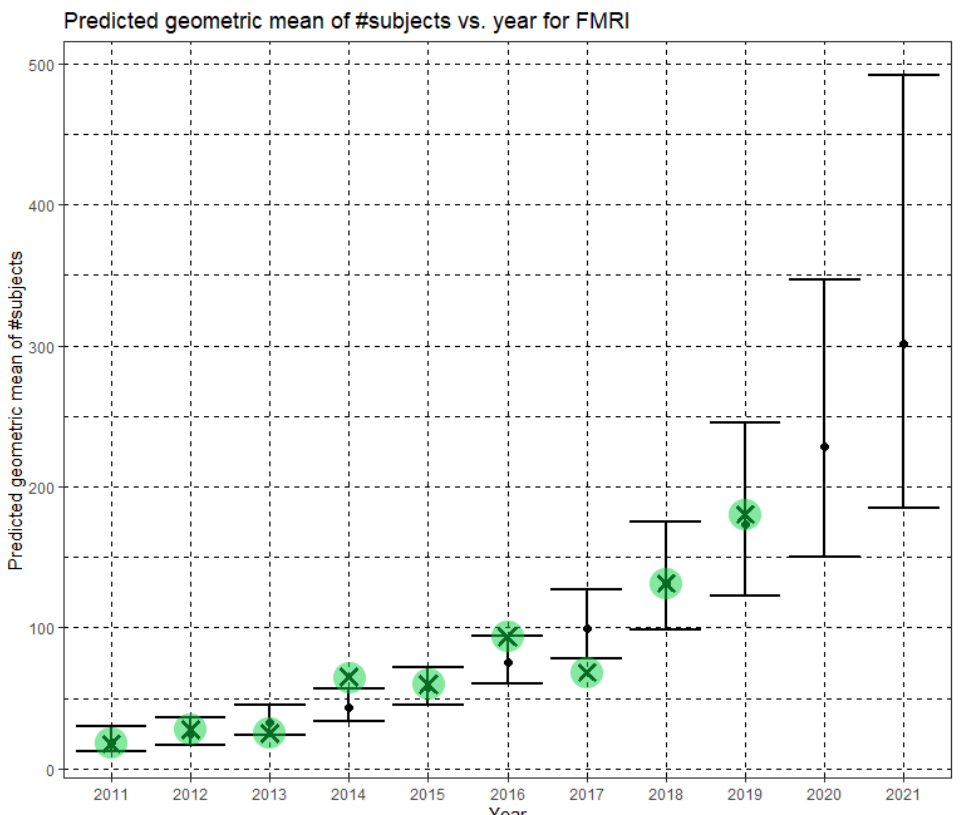
Figure 9. Phase II—Predicted geometric mean (black dots) and confidence intervals of dataset sizes in MICCAI articles involving fMRI for the years 2011–2021 based on the whole ensemble of 2011–2019 fMRI dataset sizes. The empirical geometric means (2011–2019) are shown (in green) for comparison (x marks). The empirical geometric means for 2020 and 2021 are not known at the time of writing .